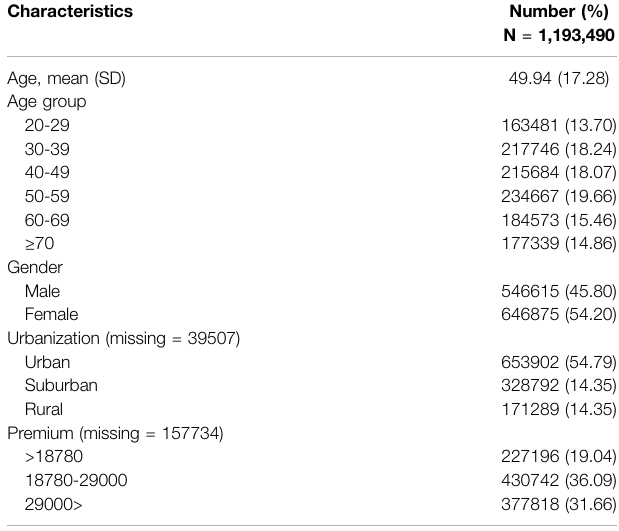
TABLE 1 | Demographic characteristics of irritable bowel syndrome population.